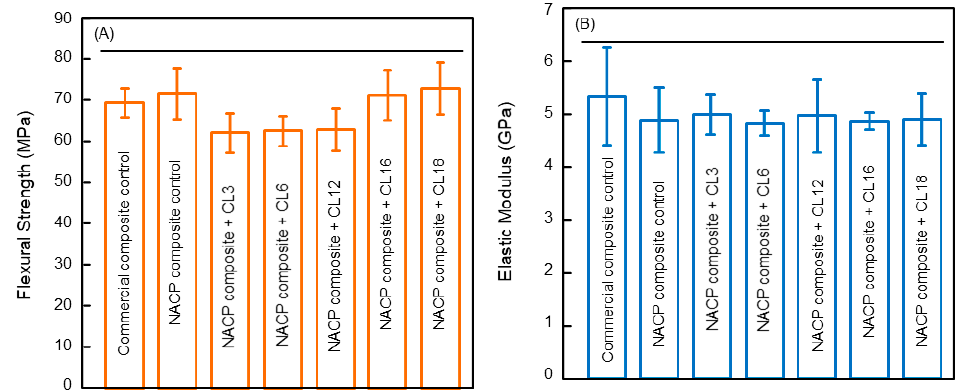
Figure 1. Mechanical properties of dental polymeric composites: ( A ) flexural strength, and ( B ) elastic modulus (mean ± SD; n = 6). Adding QAMs with amine alkyl chain length (CL) from 3 to 18 produced no significant loss in strength and elastic modulus. All QAM composites had mechanical properties similar to control composites without QAM. Horizontal line indicates p > 0.1. Adapted from [36], with permission from © 2015 Springer Nature.